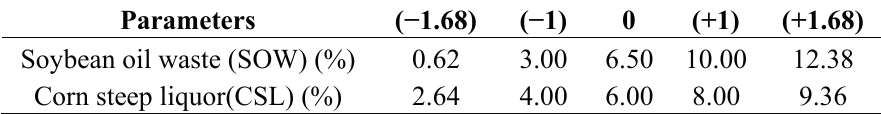
Table 3. Level and factors applied to the factorial design compound 2 2